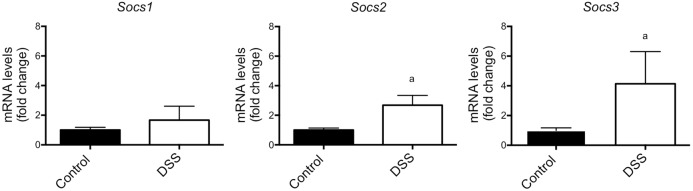
Socs mRNA expression in bone from DSS-treated WT mice.
Socs1, 2 and 3 mRNA expression levels in tibia from DSS-treated WT mice compared to control mice at day 18 (endpoint) of the DSS study. Data are presented as means±s.e.m. Control group, n=6; DSS-treated group, n=4. aSignificantly different from control samples (P<0.05) by nonparametric test (Mann–Whitney).